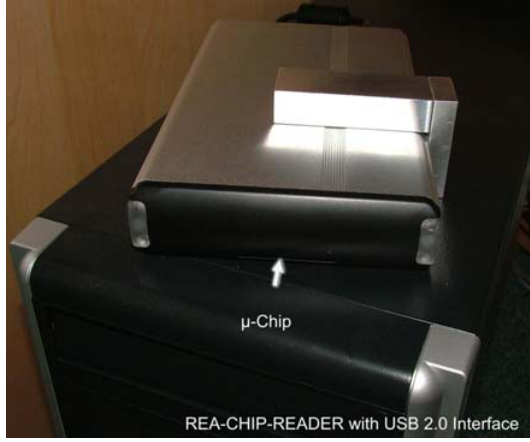
Figure 11. Novel camera-based reader for readout and quantification of the